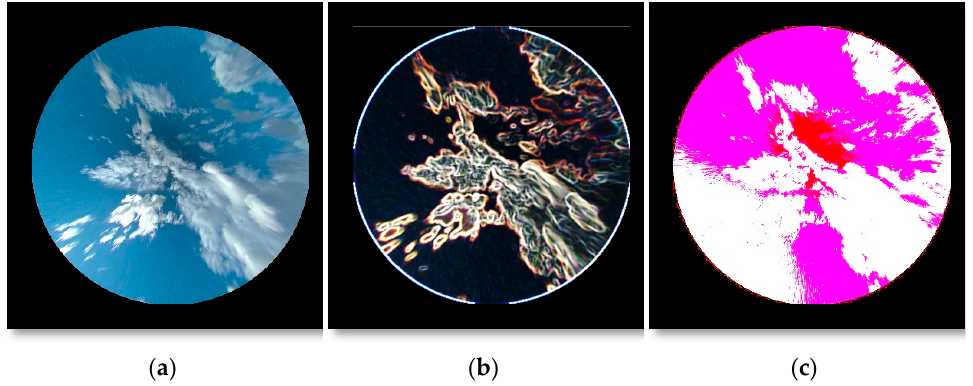
Figure 4. Evaluation of the proposed cloud decision algorithm: ( a ) Normal image captured using the full-sky imager, ( b ) the quaternion values of the image, ( c ) output image of the CA algorithm (blue–green color ratio); the back area represents CCF ratio = 1.0, blue area represents sky-free, and green is partial clouds.